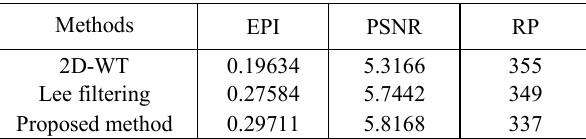
Table 1. Evaluation index values acquired from three de- noising methods.